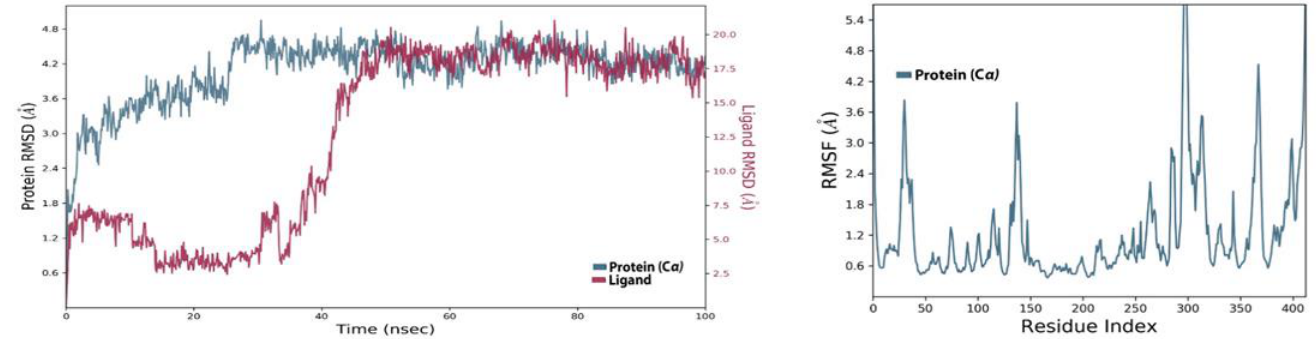
Figure 14. RMSD and RMSF of SARS-CoV-2 NSP10/NSP16 MTase and NCI-ID = 715319 1 complex.